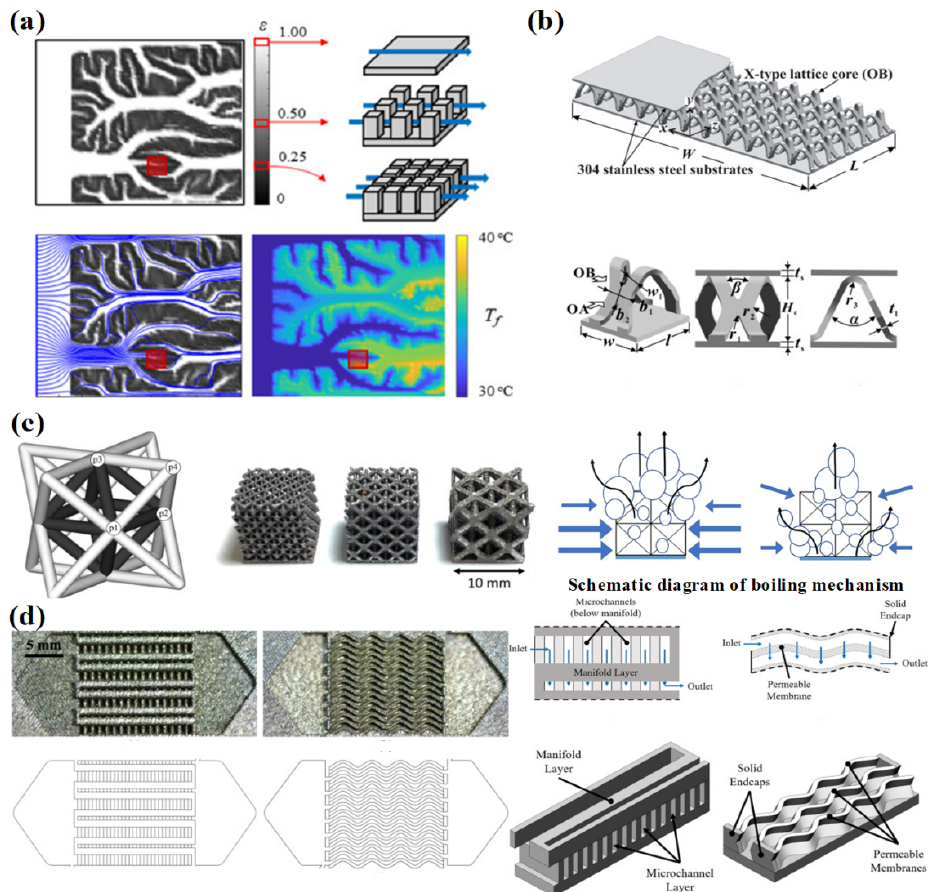
Figure 22. Schematic diagram of complex manifold hybrid microchannel: ( a ) Ozguc et al. (adapted from Ref. [139]), ( b ) Yan et al. (adapted from Ref. [140]), ( c ) Wong et al. (adapted from Ref. [27]), ( d ) Collins et al. (adapted from Ref. [141]). Table 6. Selected studies of geometric optimization on complex geometry microchannel on heat transfer.